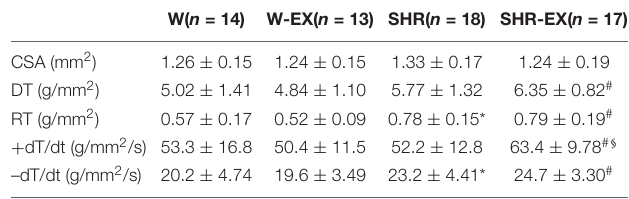
TABLE 2 | Maximum exercise test. TABLE 3 | Basal papillary muscle functional data.